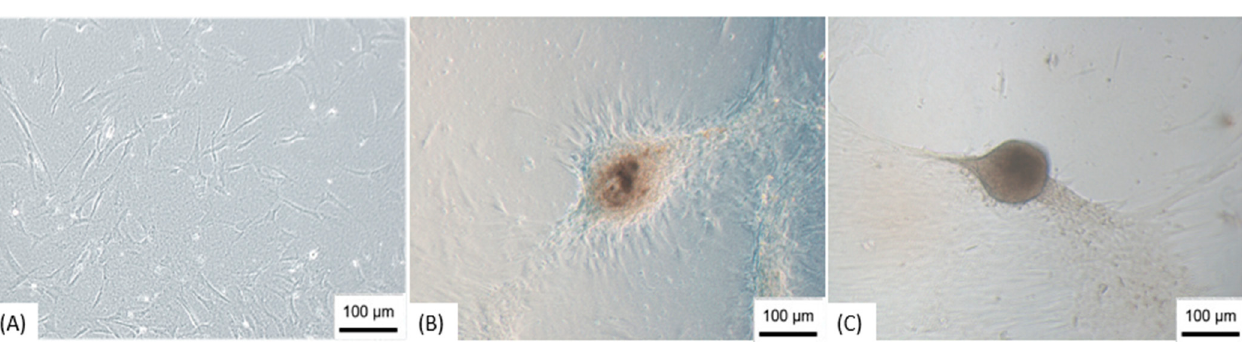
Figure 2. Development of neurospheres. ( A ) Cells three days after cultivation on NFBX membrane; ( B ) Neurosphere in formation; ( C ) Neurosphere ready to be dissociated. Note: Images obtained by inverted optical microscopy, 100×—Axio Vert. A1, Zeiss, Germany). Scale bars, 100 µm.